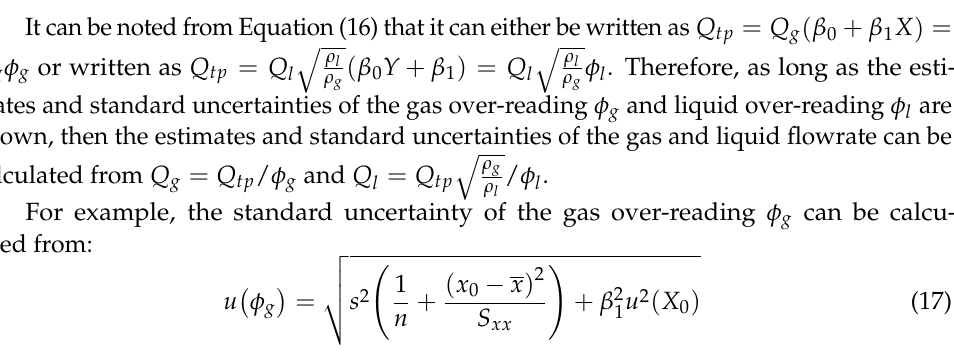
𝜌 𝑙 𝜌 𝑙 (𝛽 ) = 𝑄 𝑄 = 𝑄 𝑌 + 𝛽 𝜙 𝑡𝑝 𝑙 √ 0 1 𝑙 √ 𝑙 . Therefore, as long as the 𝜌 𝑔 𝜌 𝑔